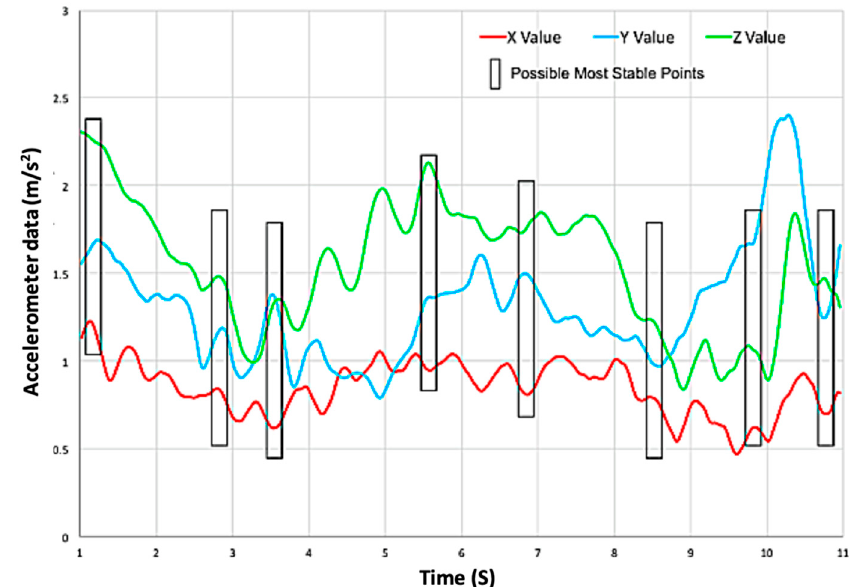
Figure 14. X, Y, and Z accelerometer data were taken by a first-time participant (minimum training). (The data has been shifted vertically for better